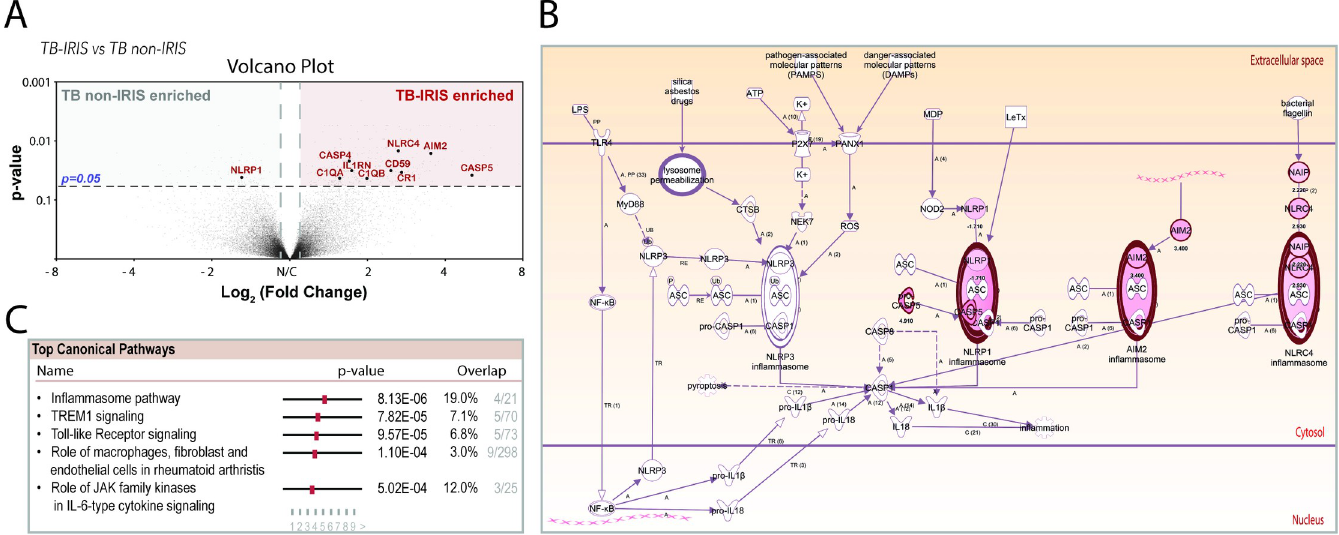
Fig 1. Transcriptional profile of peripheral blood from TB-IRIS and TB non-IRIS patients after ART. (A) Volcano plot of differentially expressed genes in TB-IRIS patients compared to TB-HIV co-infected patients who did not develop IRIS. The top differentially upregulated (log2 fold change 1.5, p = 0.05) genes related to complement and inflammasome pathways are highlighted. (B) Molecule activity prediction was performed using ingenuity pathway analysis (IPA) to predict downstream effects. Molecules in red were those found to be differentially abundant in the signatures of TB-IRIS patients when compared to TB non-IRIS participants. Molecules in light pink were predicted to be activated and arrows show predicted relationships that lead to activation. (C) Canonical pathways significantly differentially regulated are listed according to their p value, the regulation z-score algorithm to identify pathways that are upregulated (positive z-score).